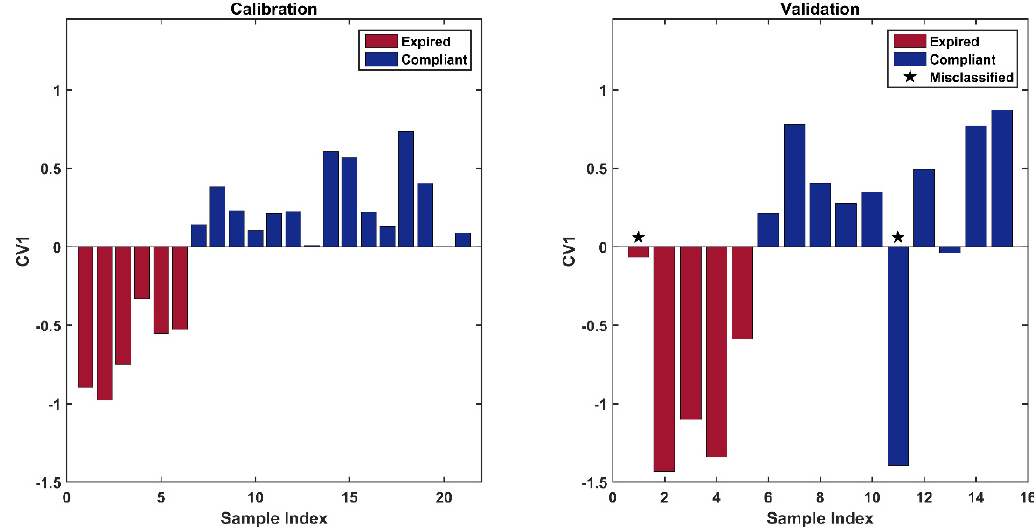
Figure 7. Canonical variate scores of calibration samples ( left plot); canonical variate scores of validation samples ( right plot). The black star indicates the misclassified sample.